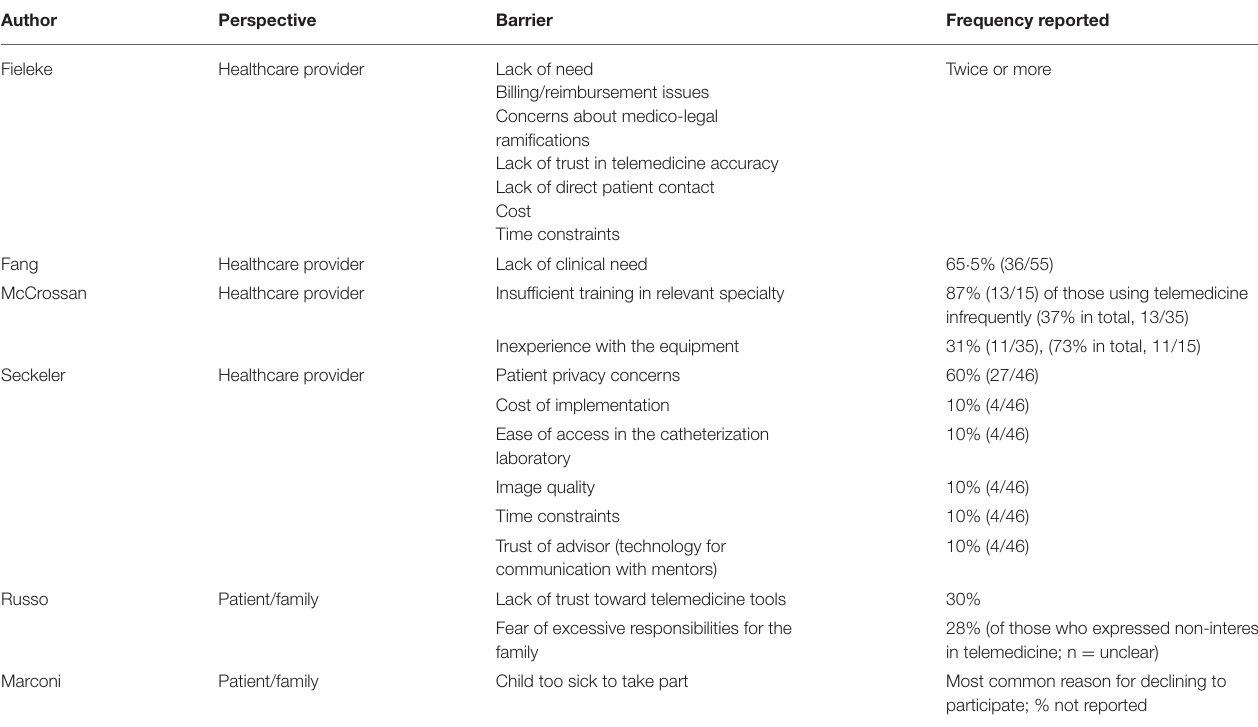
TABLE 2 | Reported barriers to initiating the use of